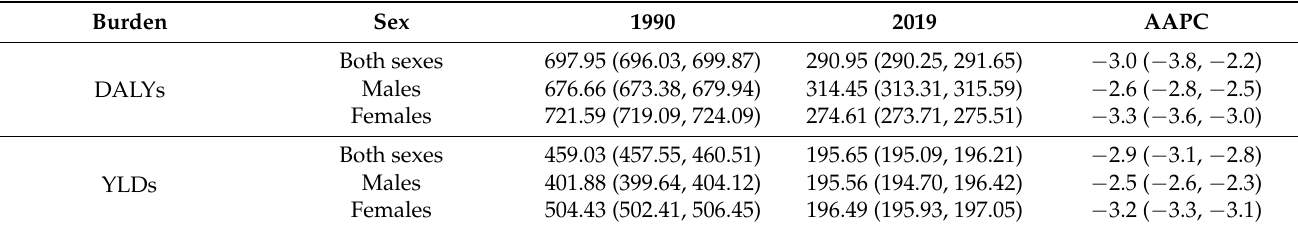
Table 1. Trends in age-standardized DALYs and YLDs rates due to nutritional deficiency among older adults (65+) from 1990 to 2019 in the Western Pacific region.